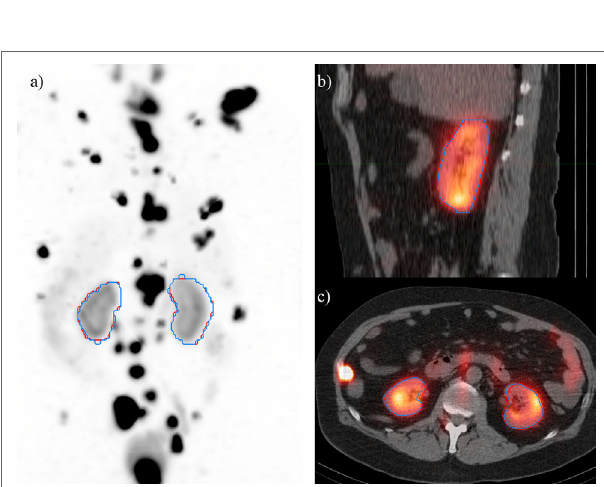
FigUre 4 | Typical case illustrating accuracy of the deep learning segmentation algorithm (red) in comparison to manual contours (blue). Contours are shown on (a) maximum intensity projection of voxel dose map, as well as (B) sagittal and (c) axial fused image sets.